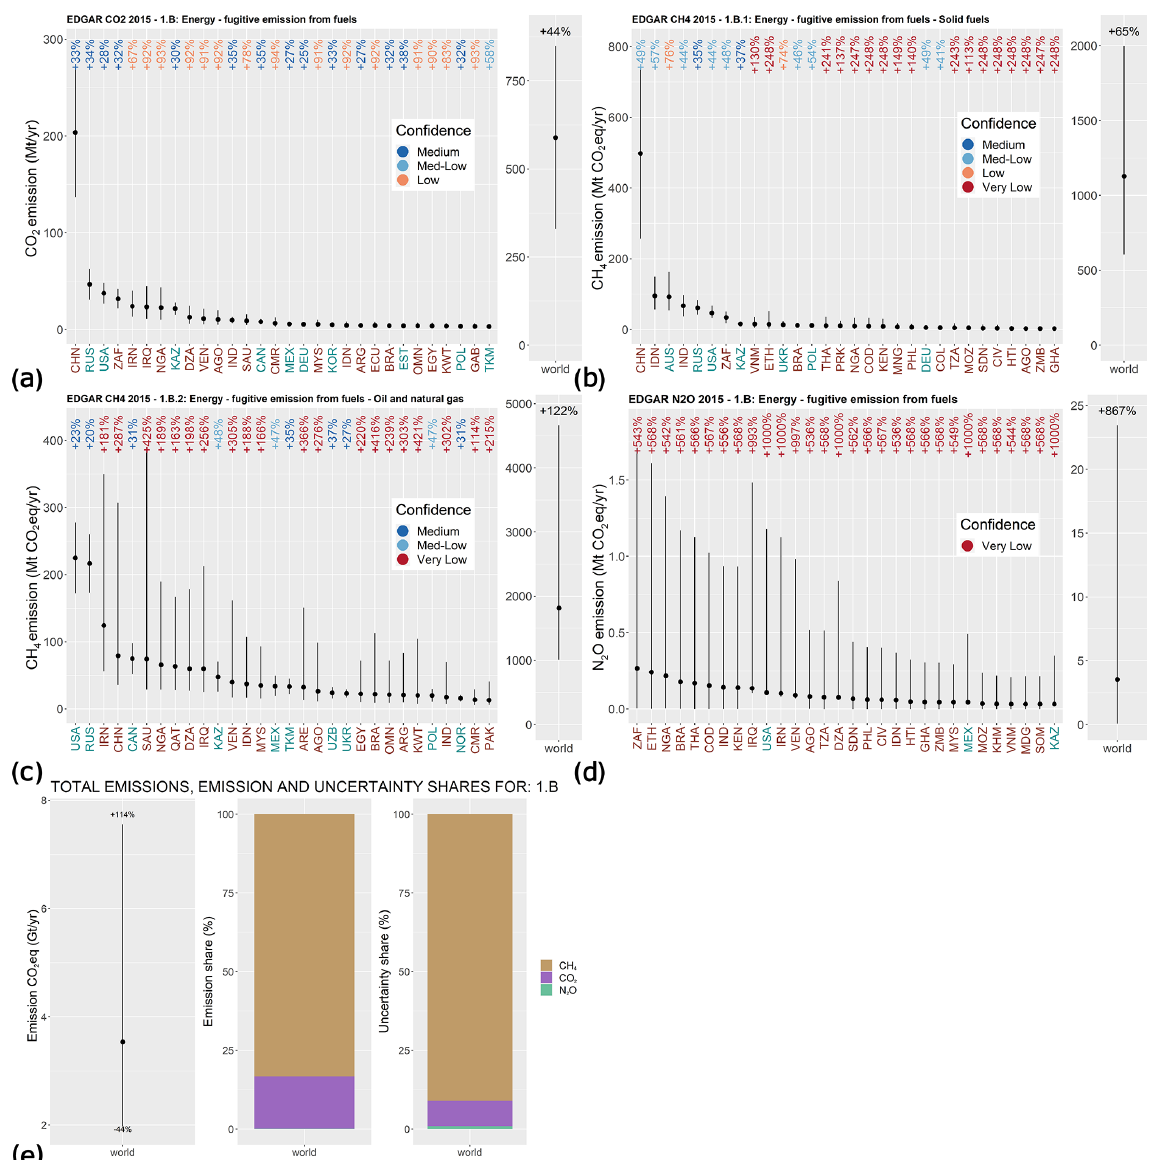
Figure 4. GHG emissions from top emitters and the world for sector 1.B (energy – fugitive emissions): (a) CO 2 from fugitive emissions from fuels; (b) CH 4 from fugitive emissions from solid fuels; (c) CH 4 from fugitive emissions from oil and natural gas; (d) N 2 O from fugitive emissions from fuels; (e) the world total emission uncertainty and the world emission and uncertainty shares. The country names are colour-coded according to their classification (cyan denotes industrialized, and red denotes developing). Confidence levels are given in the following ranges: high (0%, 10%]; medium-high (10%, 20%]; medium (20%, 40%]; medium-low (40%, 60%]; low (60%, 100%]; and very low > 100%. (Country codes are given in Table